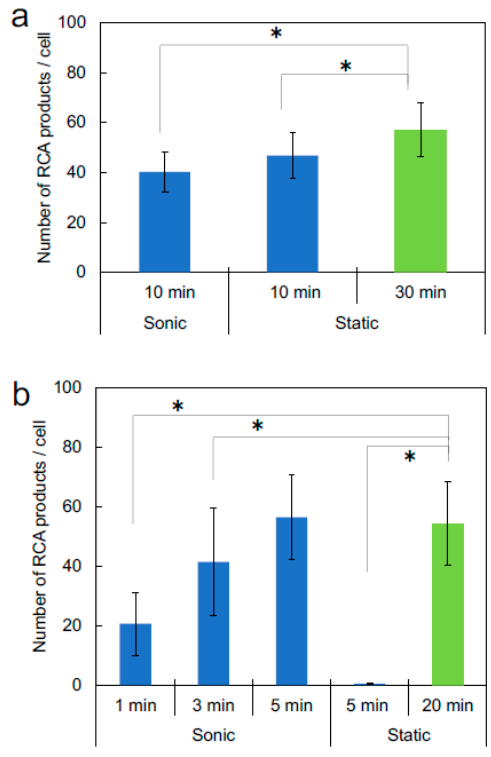
Figure 3. Effects of sonication on the number of detected RCPs. Target is mitochondrial DNA in HeLa cells. Green bars (control experiments) show results under the same reaction conditions used in a previous report [8]. Data are shown as mean ± SD ( n = 15). * p < 0.05 (unpaired two-tailed Student’s t test). ( a ) Sonication during padlock probe hybridization and ligation step. ( b ) Sonication during the